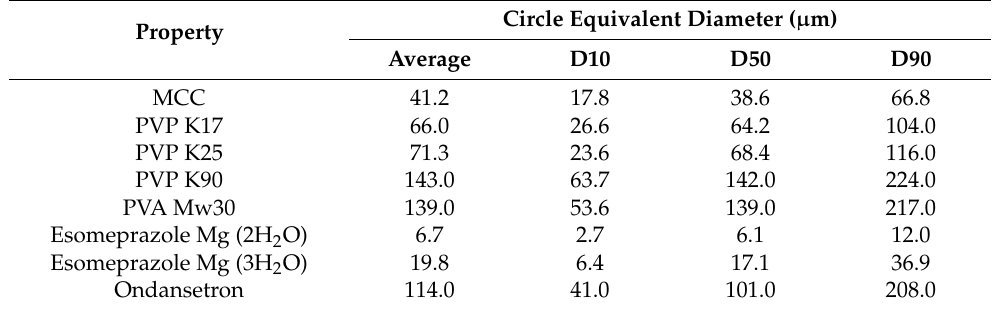
Table 2. Particle size analysis of raw materials by scanning electron microscopy (distribution by number).